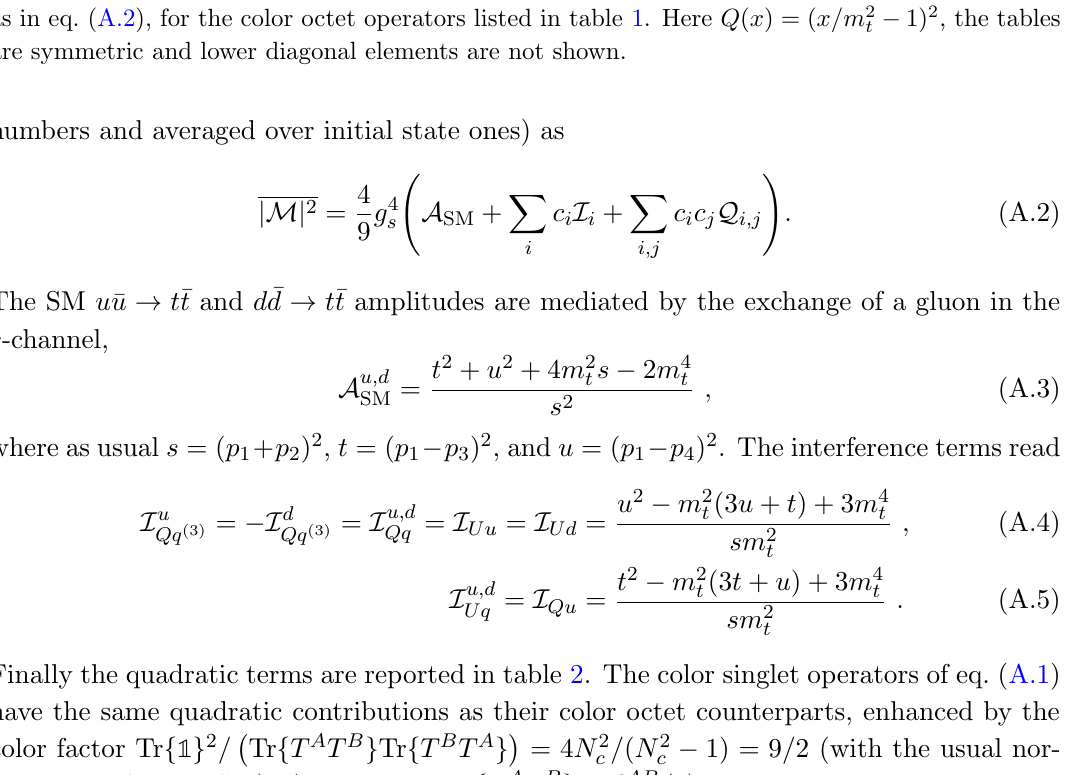
(cid:0) 1) 2 , the tables t